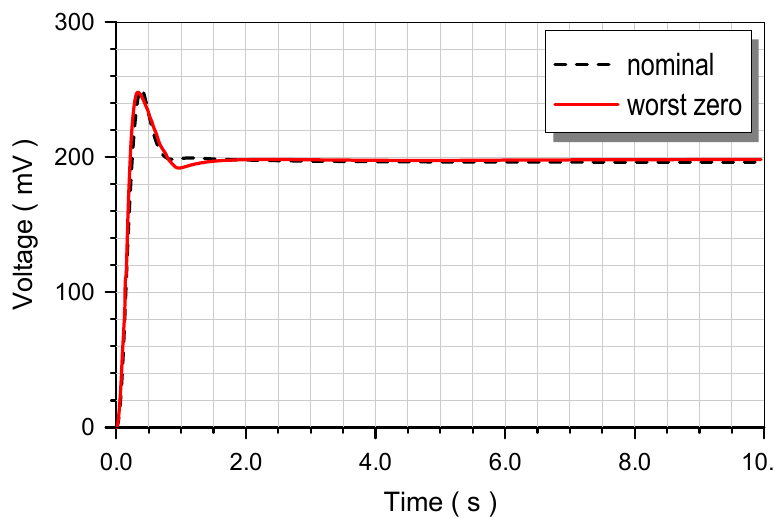
Figure 9. Worst-case step response of the system obtained through PVT corner